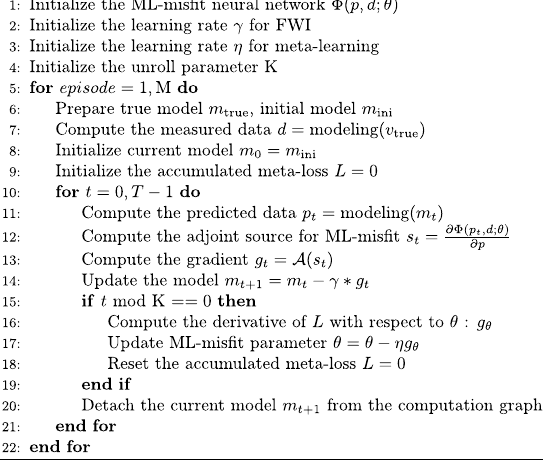
Algorithm 1. Training of the ML-mis fi